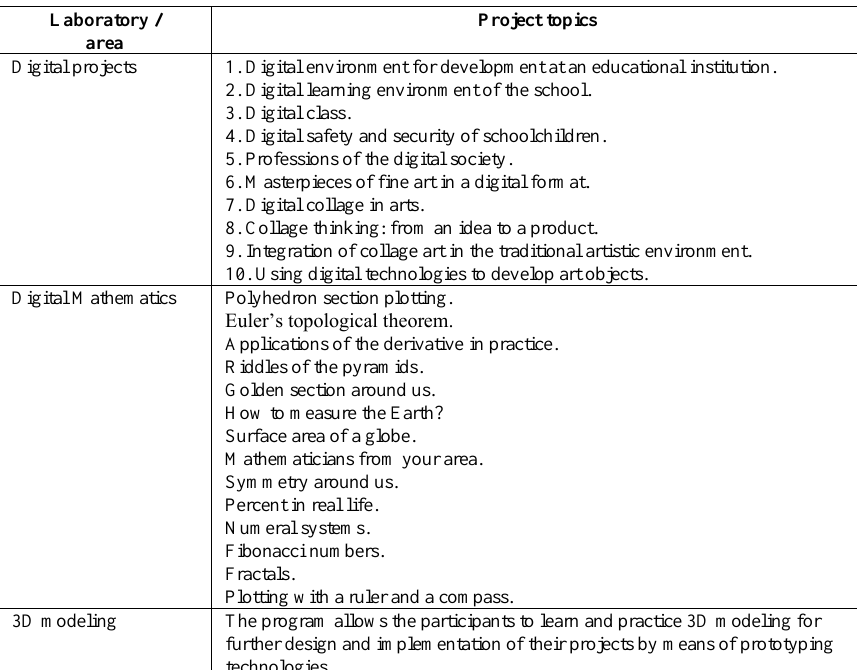
Table 2. Projects of the Digital Summer